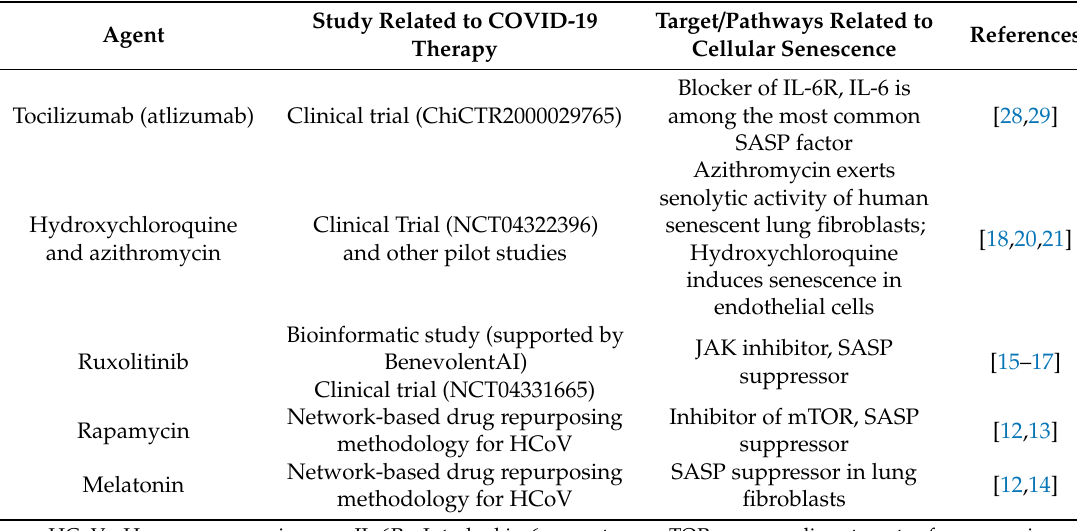
Table 1. Proposed therapies for COVID-19 targeting senescent cells or their signaling